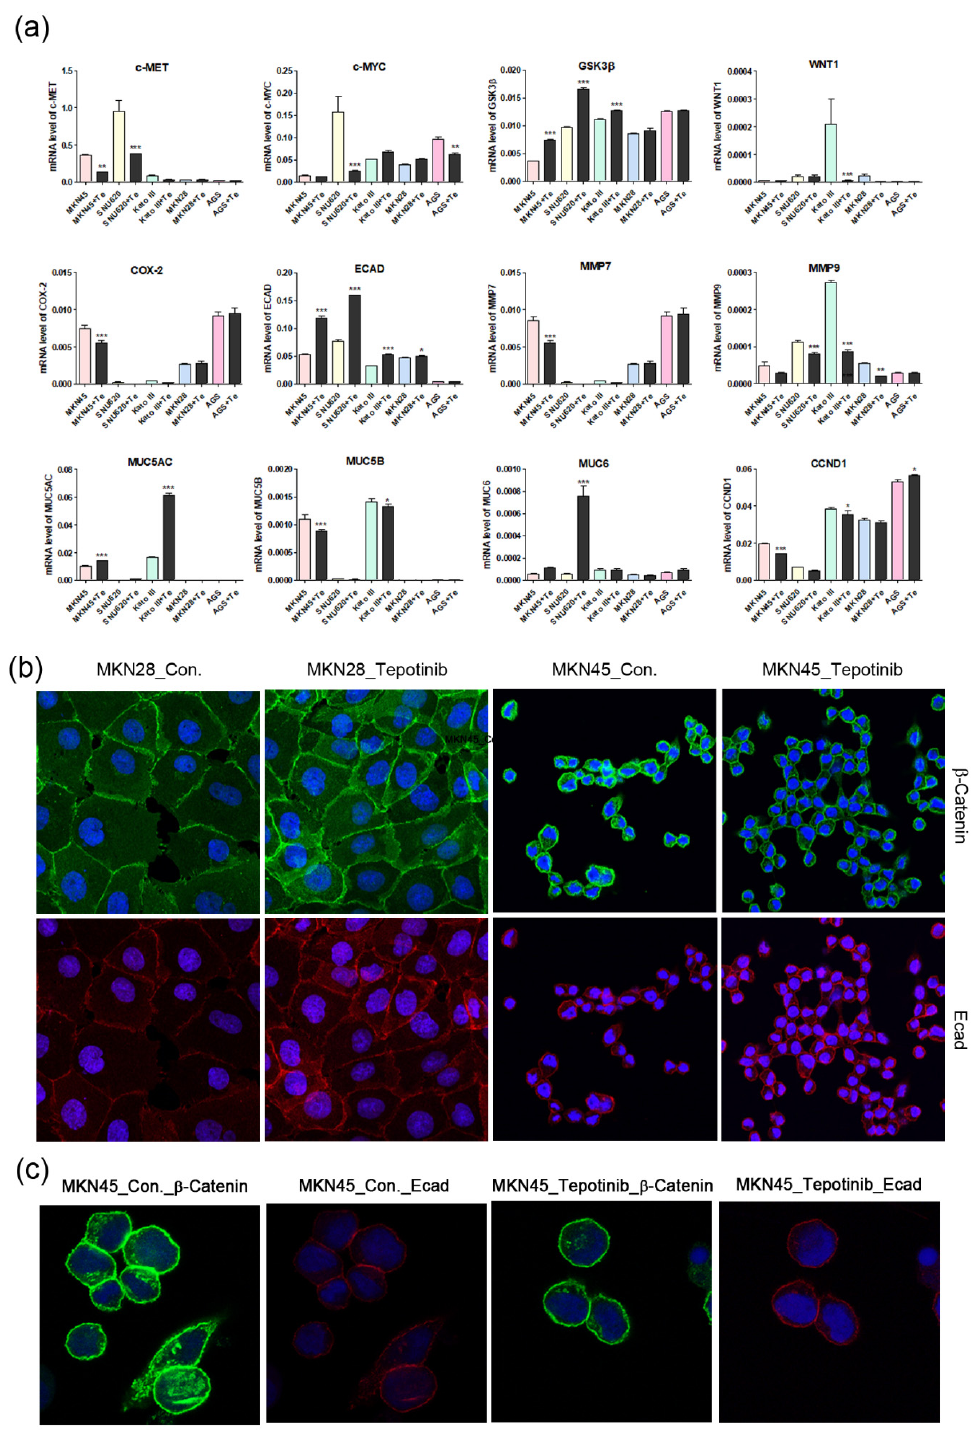
Figure 4. The e ff ects of tepotinib on epithelial–mesenchymal transition genes and proteins in GC Figure 4. The effects of tepotinib on epithelial – mesenchymal transition genes and proteins in GC cells. cells. ( a ) mRNA levels of WNT1, c-MYC, GSK3 β , MMP7, COX-2, ECAD, MUC5AC, MUC5B, ( a ) mRNA levels of WNT1, c-MYC, GSK3 β , MMP7, COX-2, ECAD, MUC5AC, MUC5B, and MUC6 in and MUC6 in MKN45, SNU620, MKN28, KATO III, and AGS cells were determined by quantitative MKN45, SNU620, MKN28, KATO III, and AGS cells were determined by quantitative reverse- reverse-transcription polymerase chain reaction after treatment with tepotinib (10 nM) for 48 h. Data are means ± standard deviation. Significant di ff erences were evaluated by one-way ANOVA; * P < 0.05; ** P < 0.01; *** P < 0.001. ( b ) Immunofluorescence staining of ECAD and β -catenin using 4 (cid:48) ,6-diamidino-2-phenylindole in MKN28 and MKN45 cells treated with tepotinib (magnification × 400). ( c ) Immunofluorescence staining of ECAD and β -catenin in MKN45 cells treated with tepotinib (magnification ×